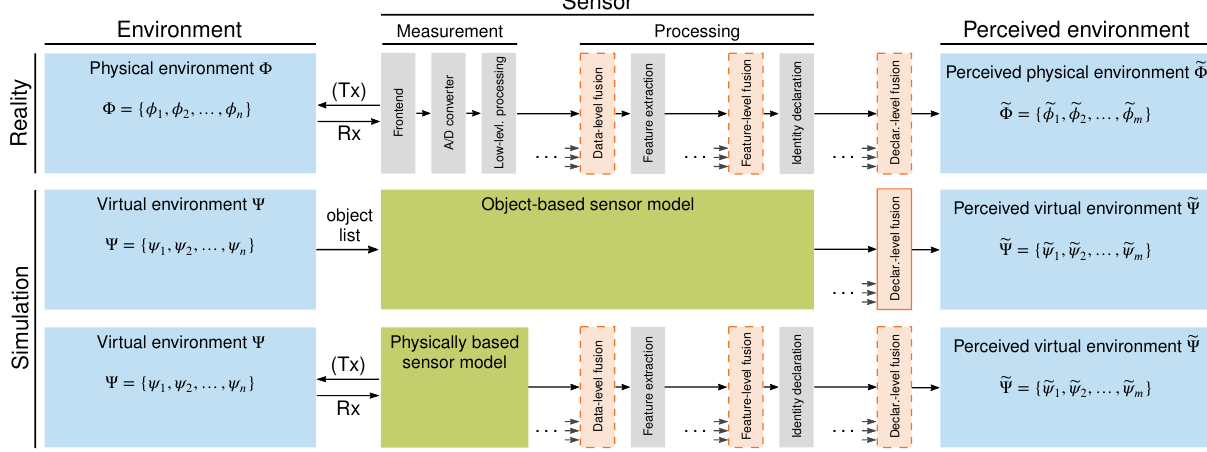
Figure 4. Architectural overview over a real sensor and the different types of sensor models, whereas the objects in the physical world Φ are denoted as 𝜙 𝑛 and the objects in the virtual world Ψ are denoted as 𝜓 𝑛 Sensor type